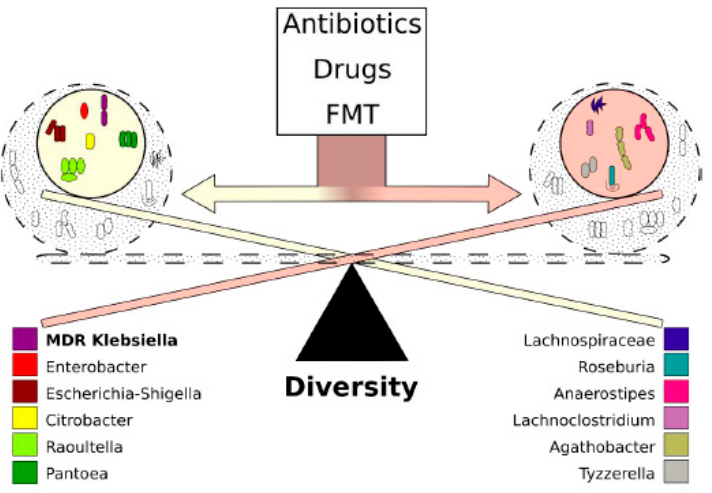
Figure 9. The dynamics of colonization with MDR K. pneumoniae. Colonization dynamics with multi-drug-resistant K. pneumoniae are determined by the behavior of microbiota-cluster groups rather than the individual vulnerability of the bacteria. One of the dominant clusters contains bacteria belonging to the Enterobacteriaceae family, whereas the other dominant cluster contains Lachnospiraceae and other short-chain fatty acid-producing bacteria. Bacteria belonging to the same cluster reinforce each other, whereas the contrasting clusters act against each other. The effect of clusters overrides the effect of individual bacteria. The balance between clusters is mostly affected by the use of antibiotics, other drugs, and fecal microbiota transplantation